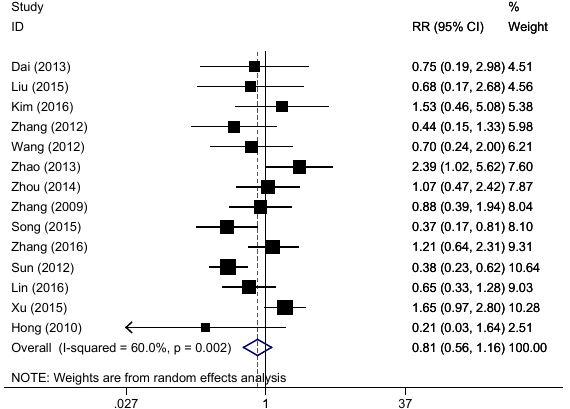
Figure 4: Forest of skin rash of Pemetrexed versus Gefitinib as second-line treatment for advanced NSCLC.